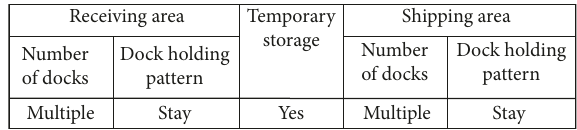
Figure 2: Studied cross-docking model [8].